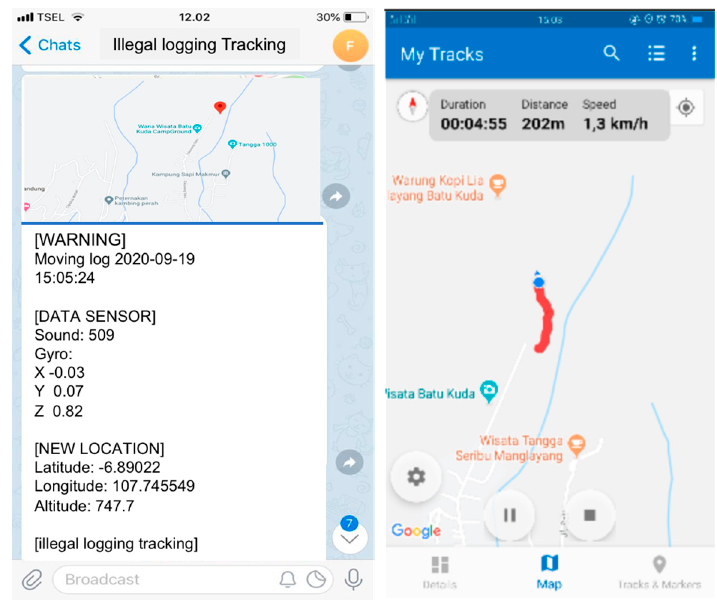
Figure 16. Telegram Display of Illegal Logging Tracking Application.